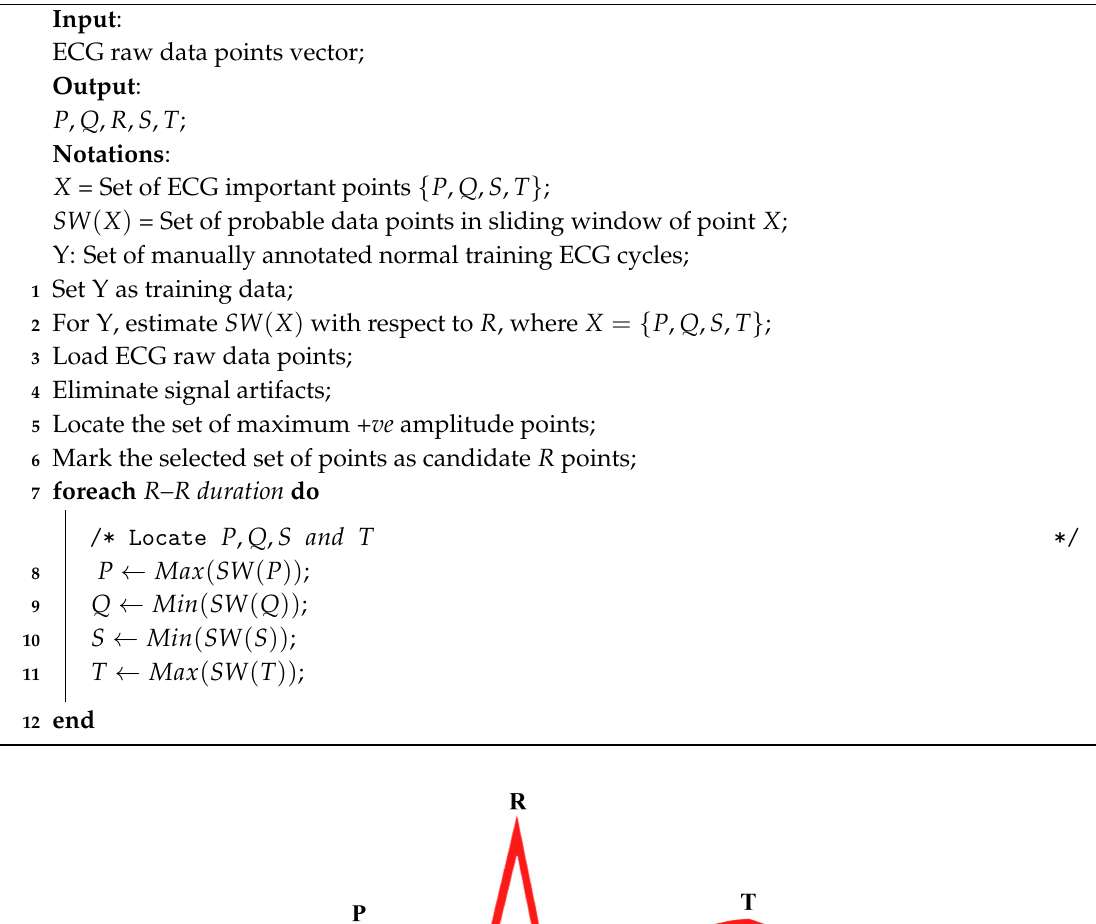
Algorithm 1: Selection of important points in ECG.